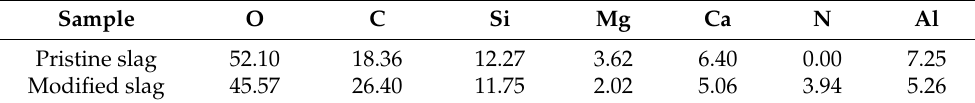
Figure 3. XPS spectra of pristine ( a ) and aminopropyl-modified ( b ) slag. Table 5. Elemental compositions (atomic %, without hydrogen) of slag determined by XPS.